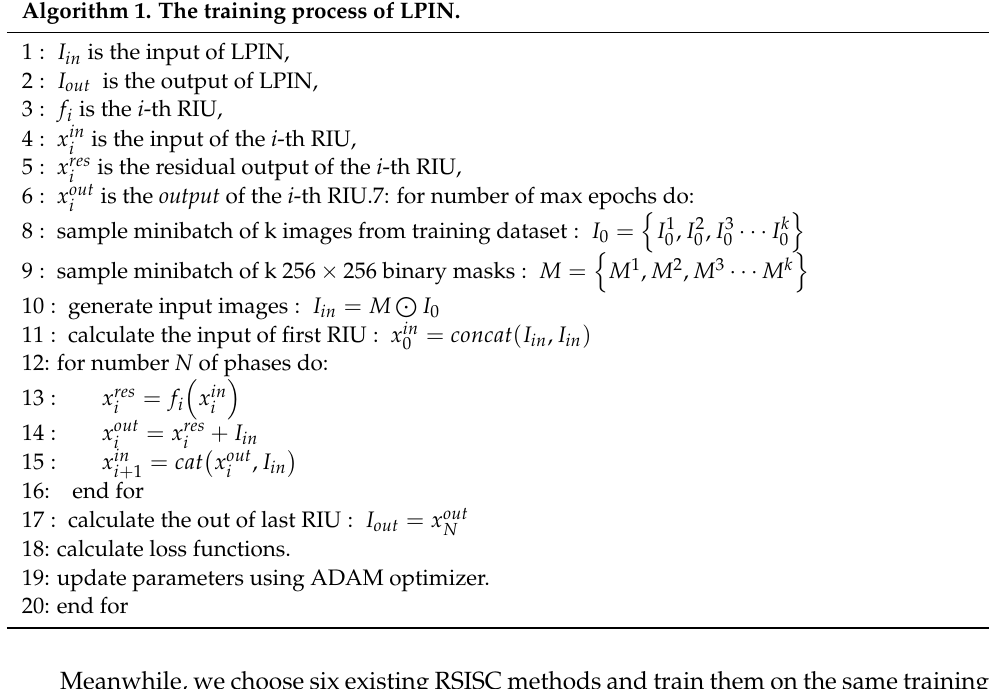
Algorithm 1. The training process of LPIN.